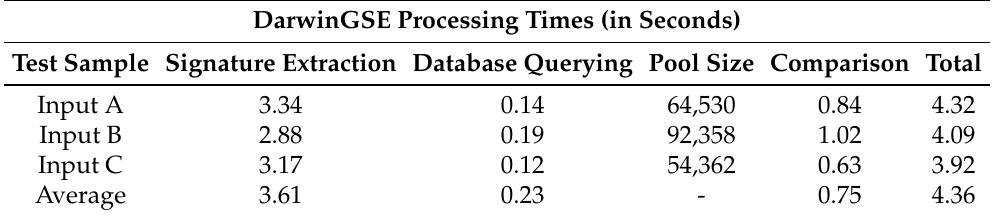
Table 2. Average system execution time for the 258 image test